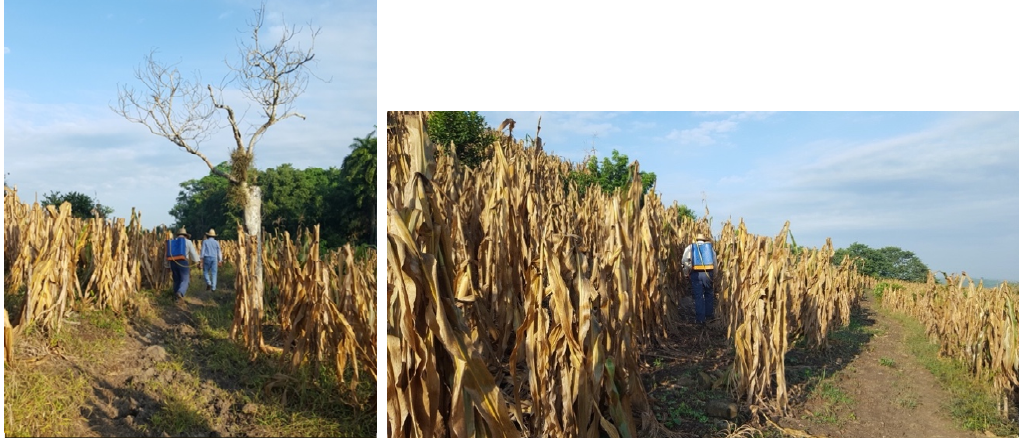
Figure 6. Farmer applying glyphosate with backpack sprayer on corn crops.